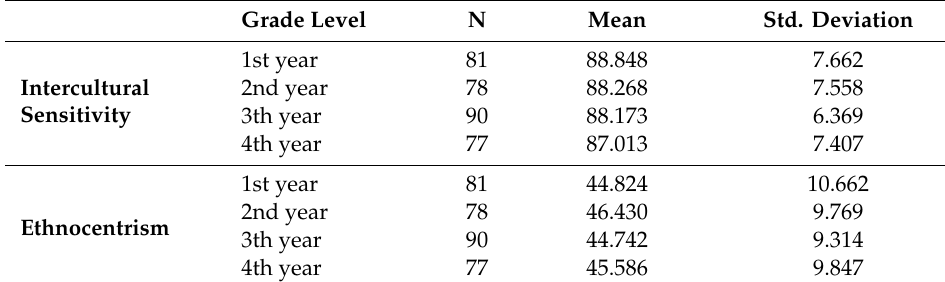
Table 5. Mean and standard deviation of students’ scores by grades received in the Intercultural Sensitivity Scale and the Ethnocentrism